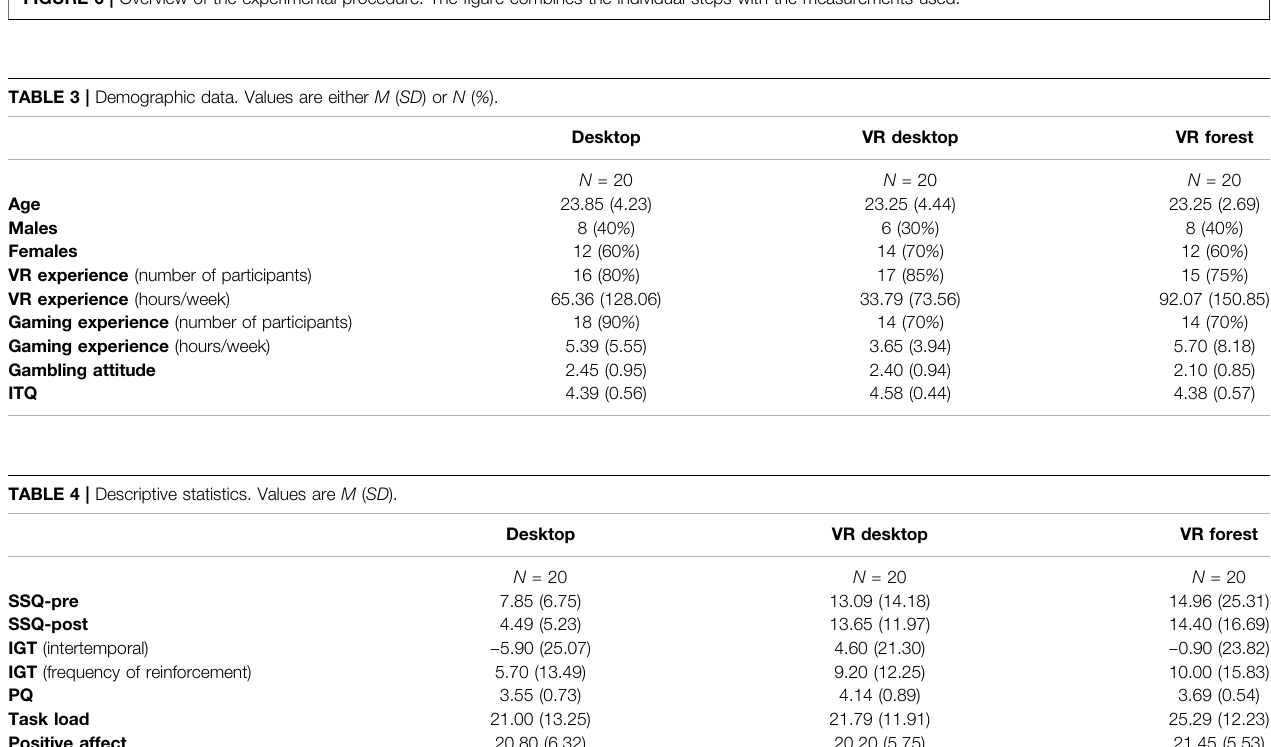
FIGURE 6 | Overview of the experimental procedure. The fi gure combines the individual steps with the measurements used.